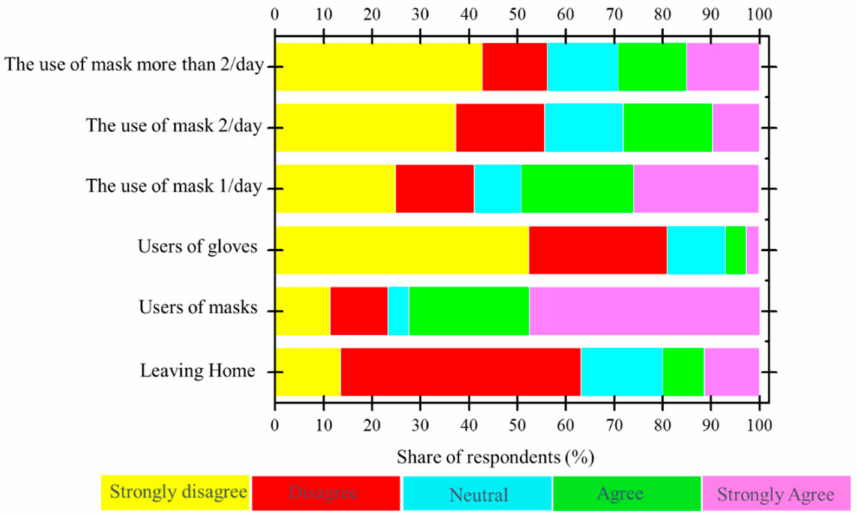
Figure 6. Frequency of the use of facemasks and